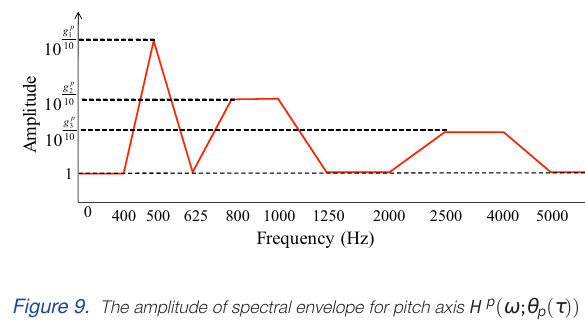
scarcely holds in the case a sound source is only 100 cm away from the microphones.